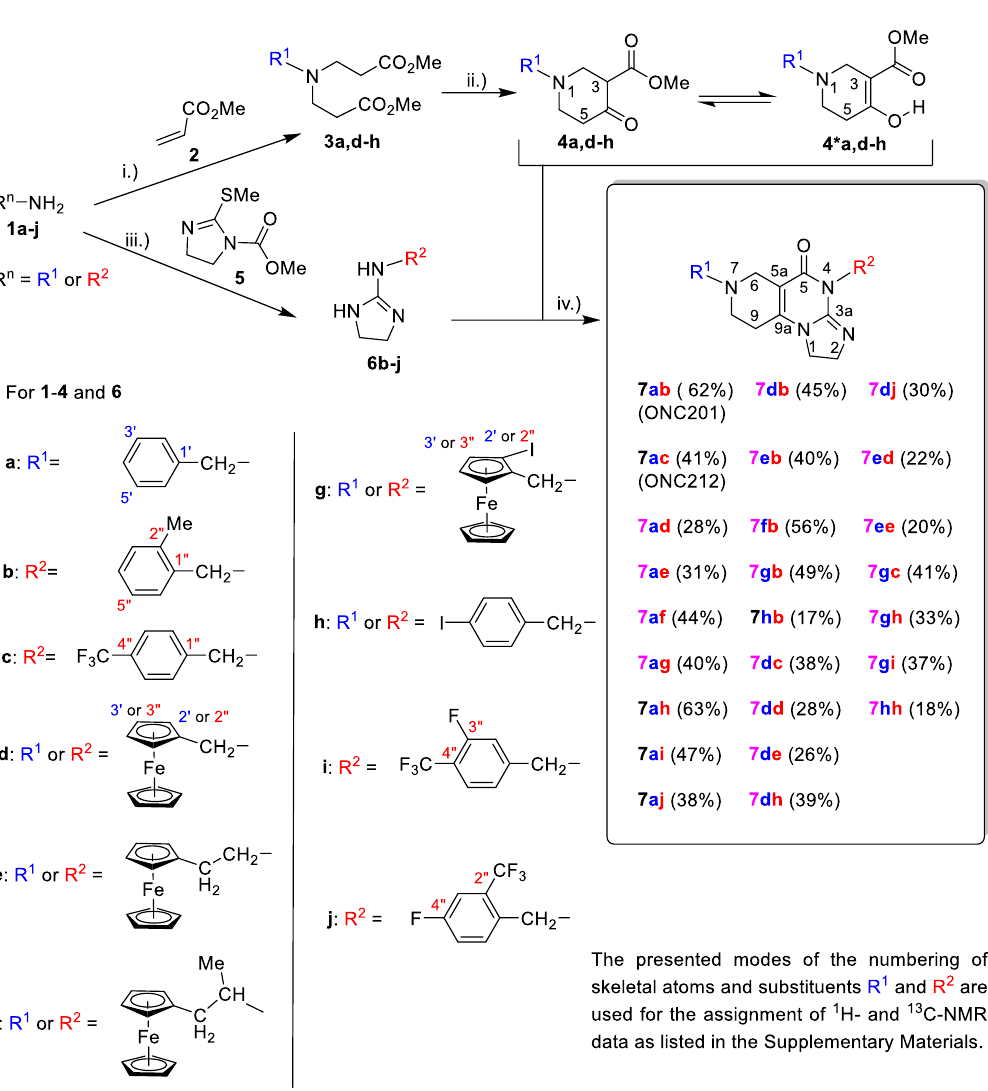
Scheme 1. Synthetic route of novel ferrocene hybrids of ONC201 with compounds